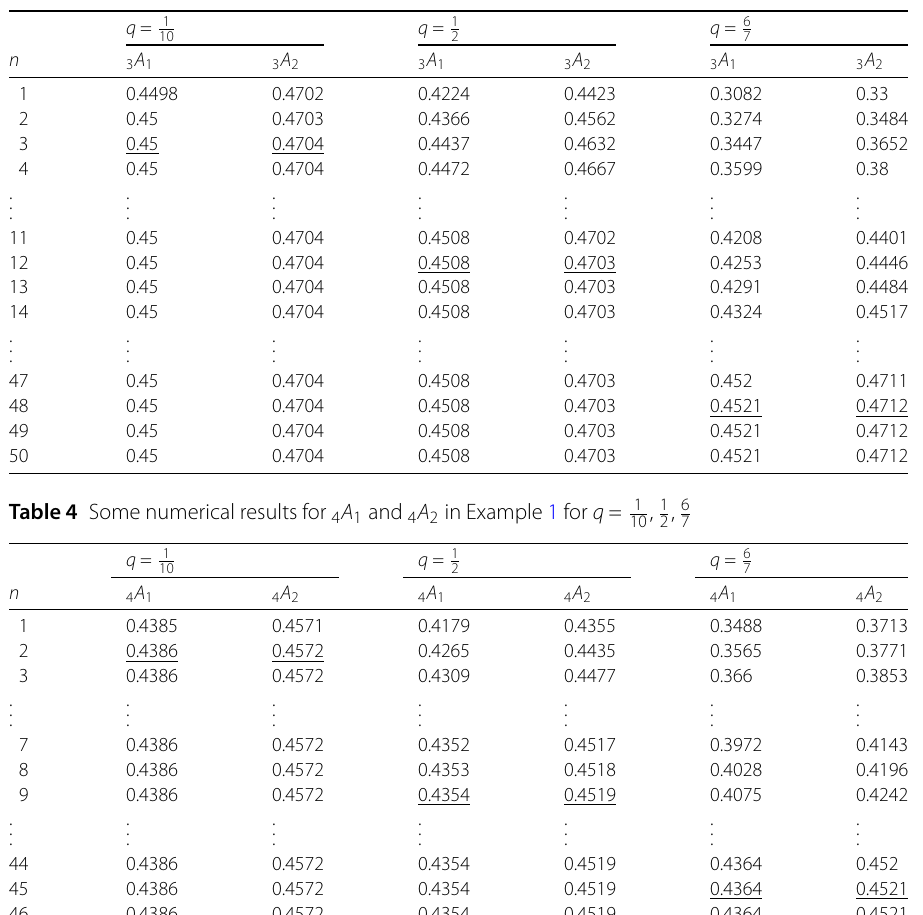
Table 3 Some numerical results for 3 A 1 and 3 A 2 in Example 1 for q = 1